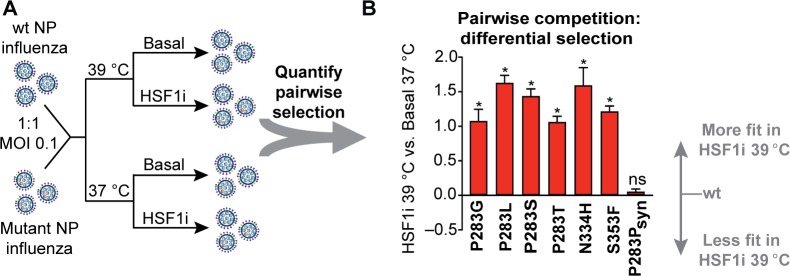
Pairwise competitions between highly selected variants and wt NP recapitulate the bulk competition results.(A) Pairwise viral competition scheme: wt NP influenza was mixed with mutant NP influenza in an approximately 1:1 ratio and was then subjected to selection during replication at 37 °C and 39 °C in both basal and chaperone-depleted (HSF1i) cells at an MOI of 0.1 virions/cell. The differential selection for each NP mutant was assessed by deep sequencing the viral competition mixture following selection. Mutation differential selection was evaluated as the logarithm of the enrichment of the corresponding variant. (B) Differential selection of NP variants upon chaperone depletion at 39 °C relative to basal chaperone levels at 37 °C during pairwise competitions. Error bars indicate the standard error from biological replicates (N = 3). The significance of deviation from zero (no selection) was evaluated by a one-sample t test followed by FDR adjustment of corresponding p-values; * indicates an FDR < 0.05. Differential selection values for pairwise competitions are provided in S5 Data. FDR, false discovery rate; HSF1i, condition in which heat shock factor 1 was inhibited; MOI, multiplicity of infection; NP, nucleoprotein; ns, not significant; syn, synonymous; wt, wild type.